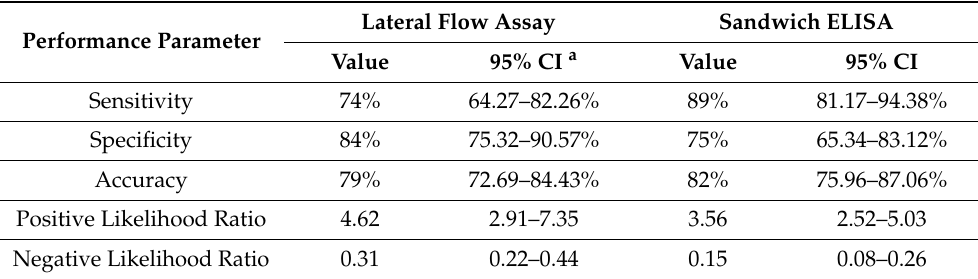
Table 1. Clinical performance of the IMMY s¯ona Aspergillus GM lateral flow assay and the Bio-Rad Platelia sandwich ELISA when testing serum samples from non-neutropenic patients with pulmonary infections and control healthy individuals based on the cut-off values determined by the manufacturer of each